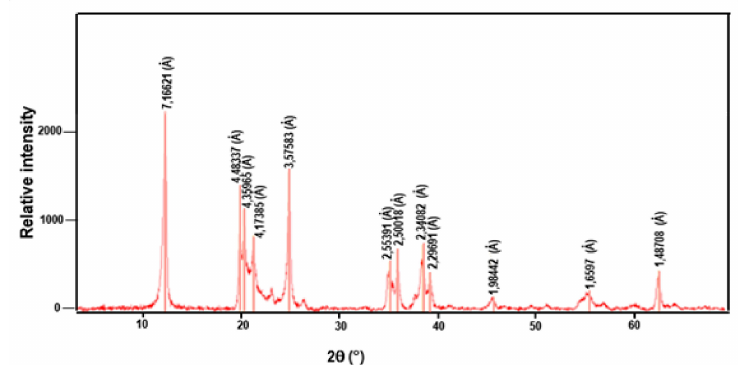
Figure 2. X-ray diffraction diagram of the Tabarka clay. Table 1. Chemical composition of Tunisian clay from the Tabarka region (wt.%).